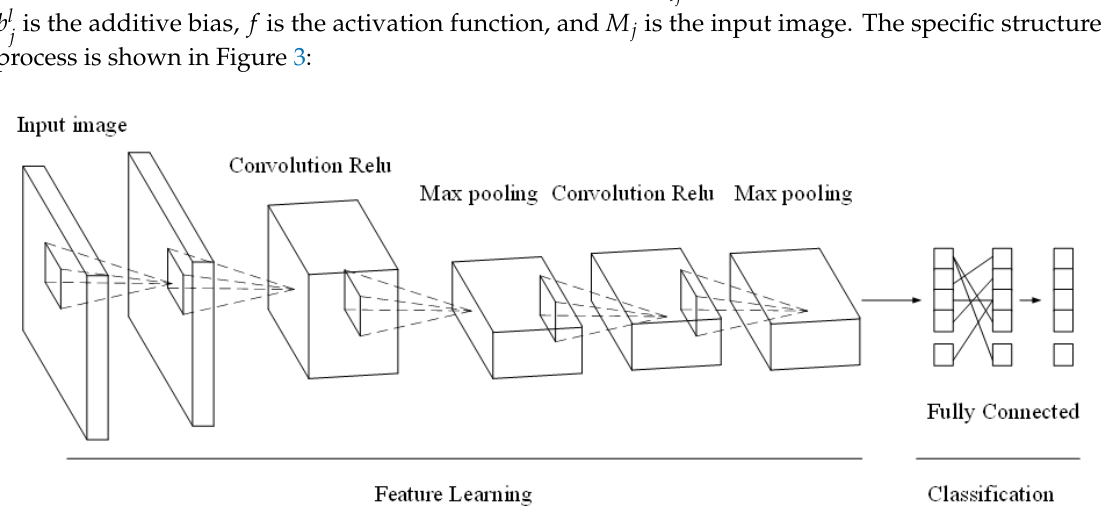
Figure 3. Structure of the deep learning convolution layer.